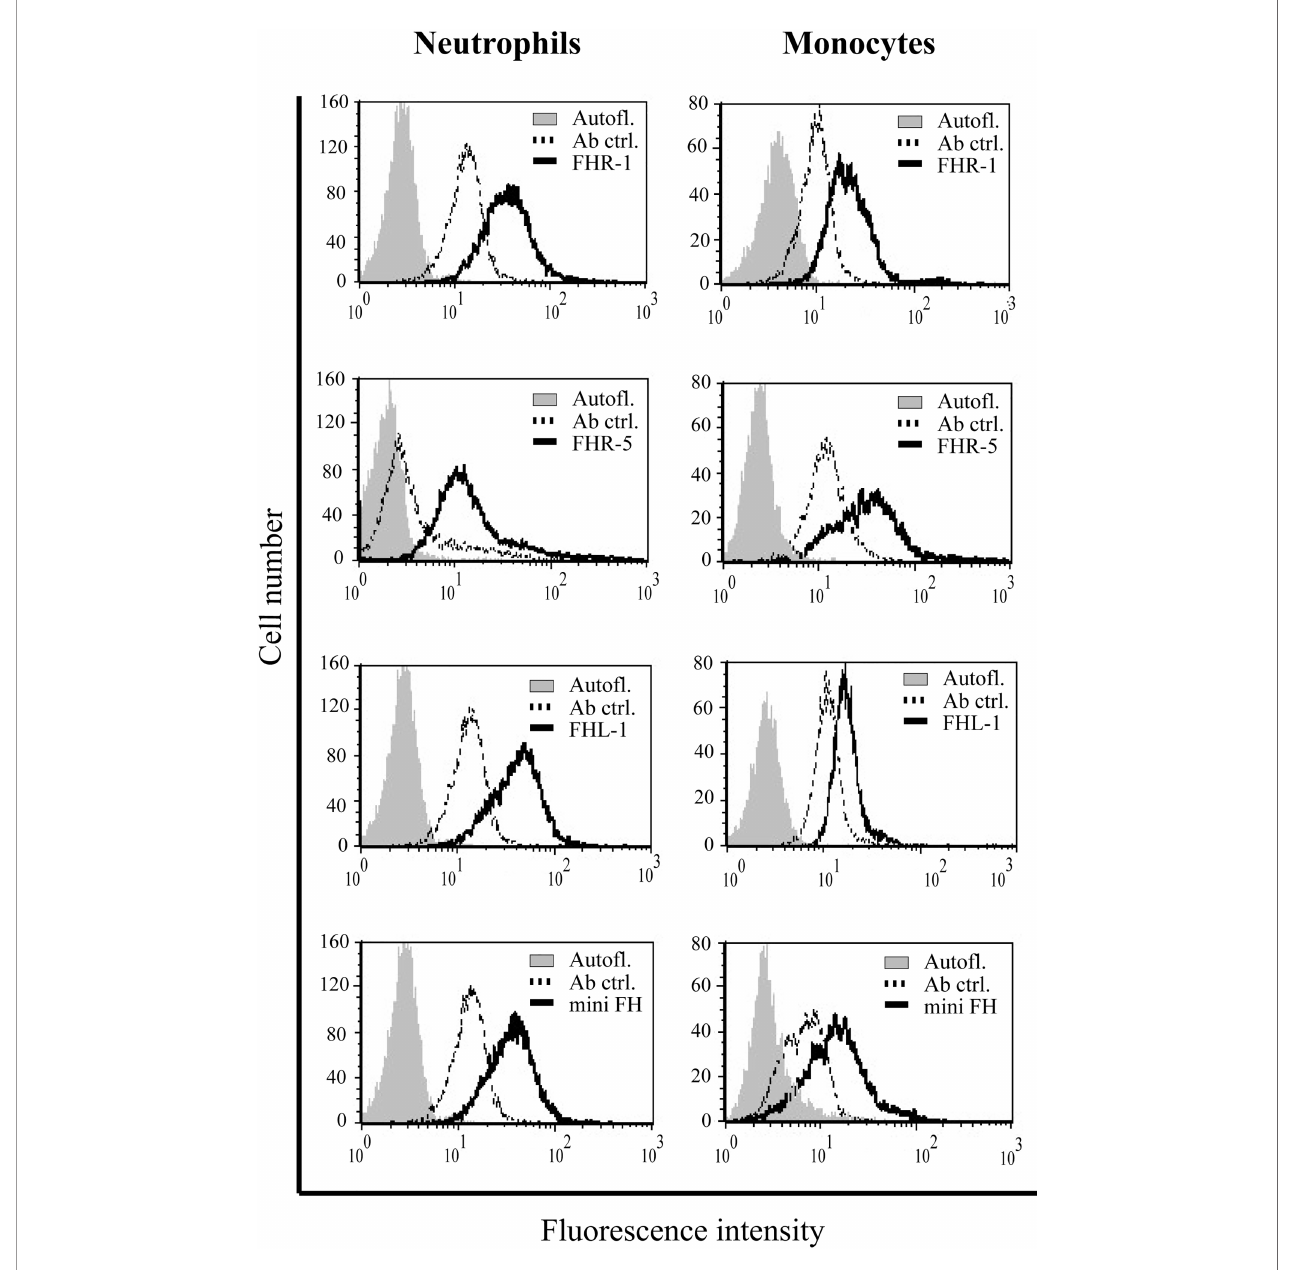
FIGURE 1 | FHR-1, FHR-5, FHL-1 and mini-FH bind to primary neutrophil granulocytes and monocytes. Binding of 300 nM of each protein (solid lines) to neutrophil granulocytes and monocytes in Ca 2+ and Mg 2+ containing DPBS was measured by fl ow cytometry. Filled histograms indicate auto fl uorescence, dotted lines show samples incubated without the proteins added (antibody controls). Binding of the added proteins (solid black line) was analyzed using polyclonal anti-FH Ab for FHR-1, FHL-1 and mini-FH detection, and monoclonal anti-FHR-5 for FHR-5 detection. A representative histogram out of three independent experiments is shown in each